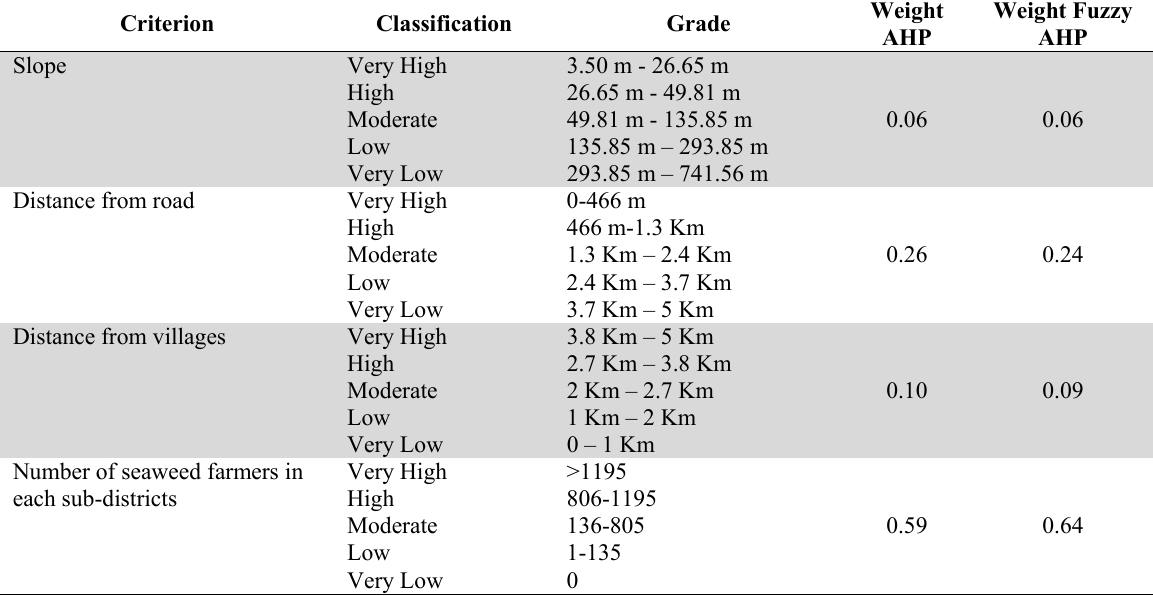
Grading and Evaluation Criterion